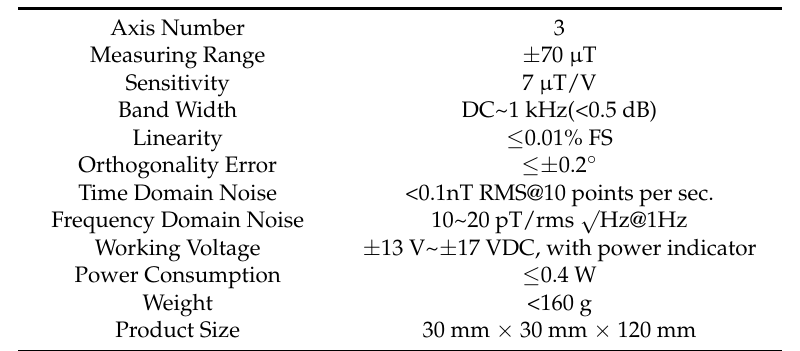
Table A1. The technical parameters of HS-MS-FG-3LN fluxgate sensor.